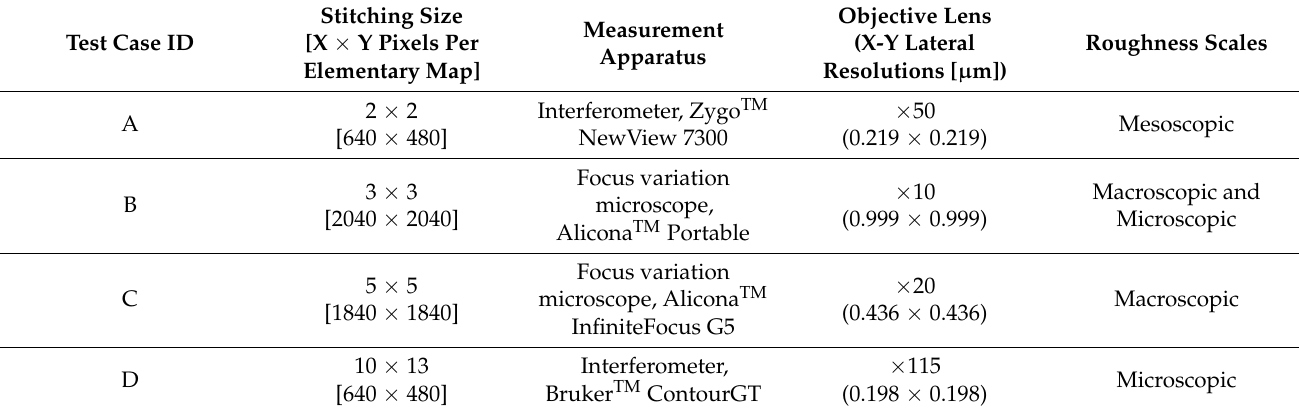
Table 2. Measurement configurations for stitching test